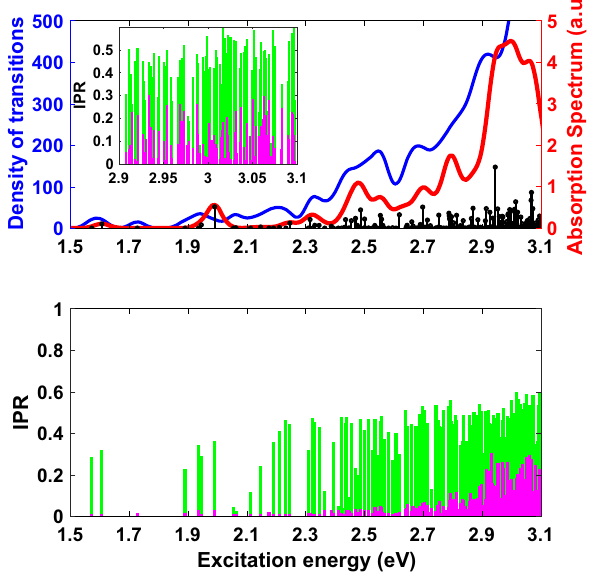
Fig. 1 Spectrum and IPR for the 2 nm, methylamine-passivated Cd 91 Se 91 . Top: Absorption spectrum in arbitrary units (red) and density of transitions (blue). Black sticks show individual excited states, whose oscillator strengths have been broadened to create the absorption spectrum. Note the high density of states with little or no oscillator strength (i.e. dark states). Bottom: Inverse participation ratio (IPR) for electrons (green) and holes (magenta) for each excitation. A larger IPR corresponds to a more delocalized wavefunction. Clearly the dark, low-energy states are associated with localized states, while the bright states are signi fi cantly delocalized. Inset: Enlarged plot of the IPR for the higher-energy part of the excitation spectrum, i.e. E ex > 2.9